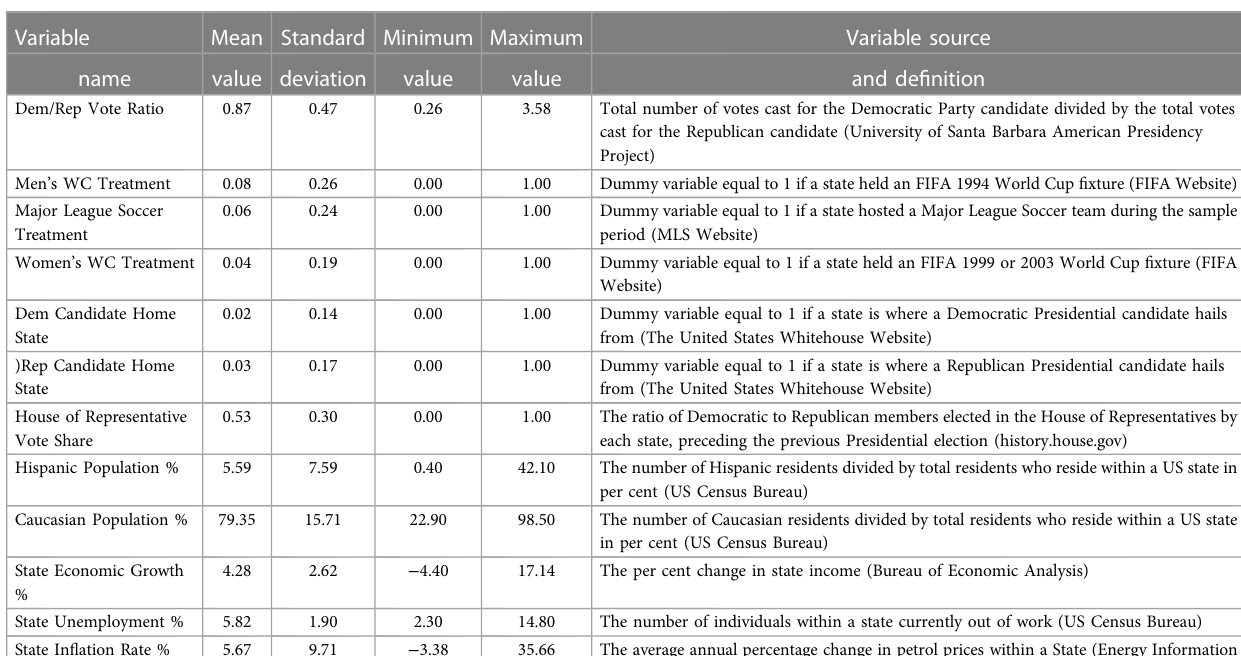
TABLE 1 Summary